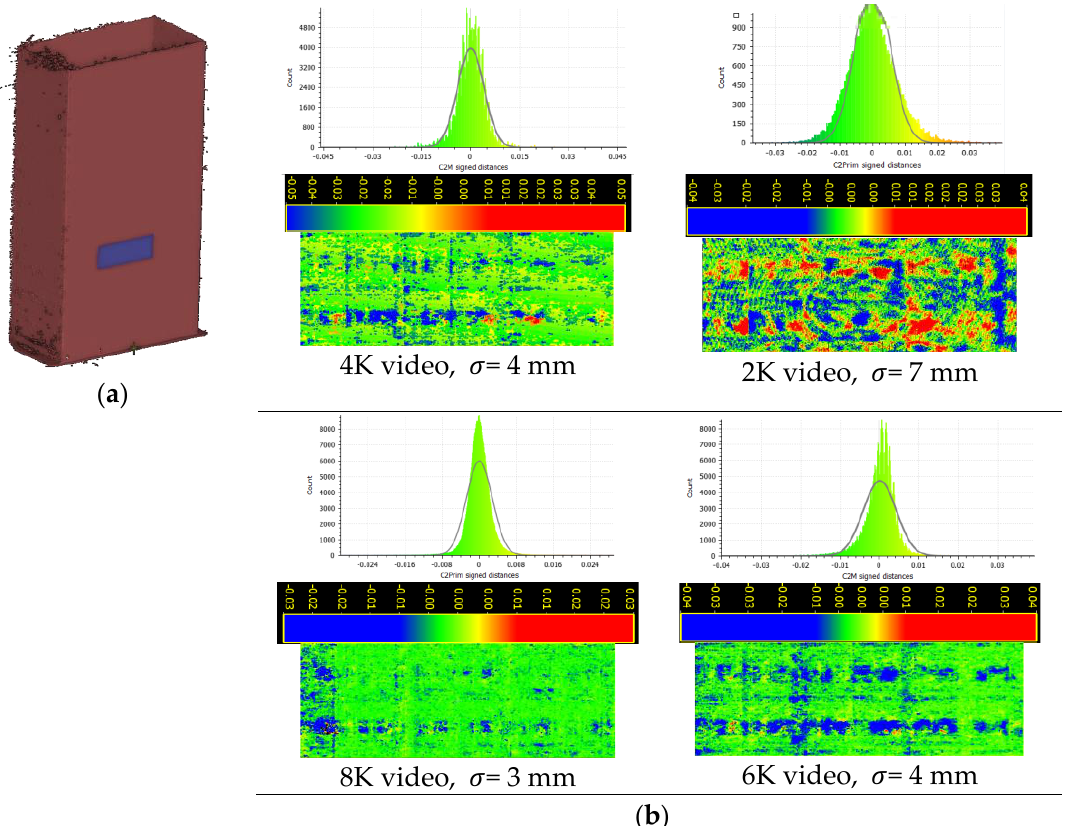
Figure 15. Checking the internal accuracy of the second test. ( a ) The selected planar façade (blue patch) for testing the relative accuracy. ( b ) Planar fitting error evaluation at the four video resolutions.